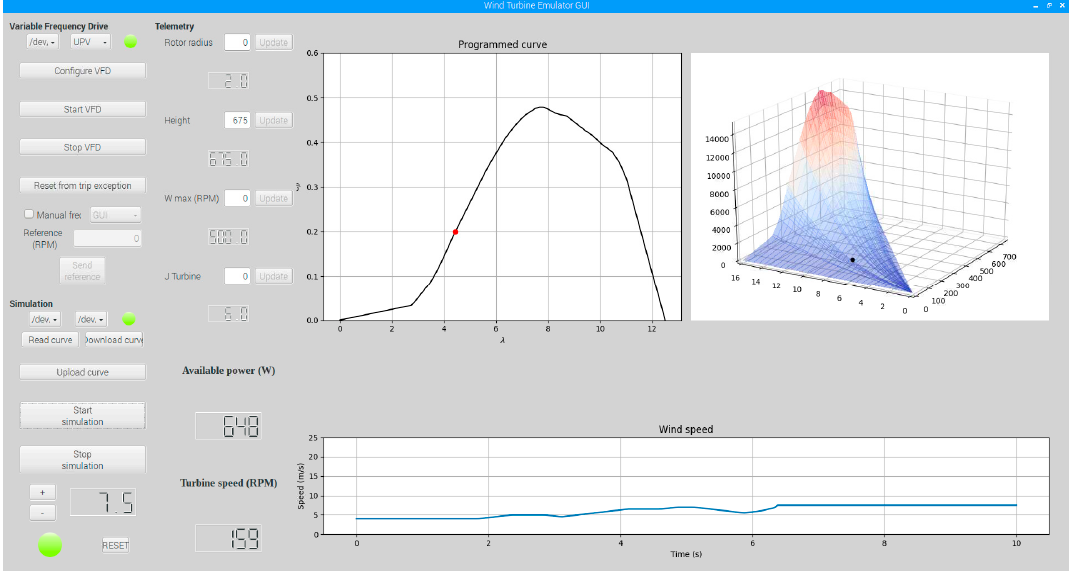
Figure 17. Graphic user interface (GUI) of the wind turbine emulator system. Visualization of the real-time operating point during emulation.